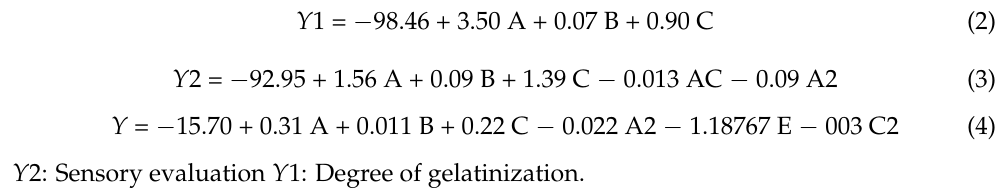
Y 2: Sensory evaluation Y 1: Degree of gelatinization. Table 3. Variance analysis of quadratic regression model for response surface experiment. Mean- Sum of F p df Square Square